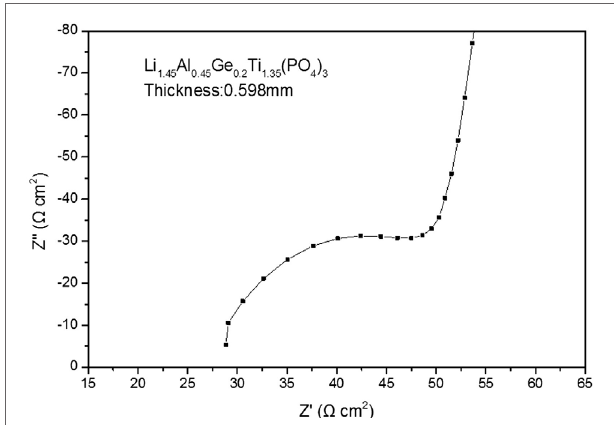
FigUre 12 | impedance profile of the tape cast li 1.45 al 0.45 ge 0.2 Ti 1.35 (PO 4 ) 3 film measured at 25°c